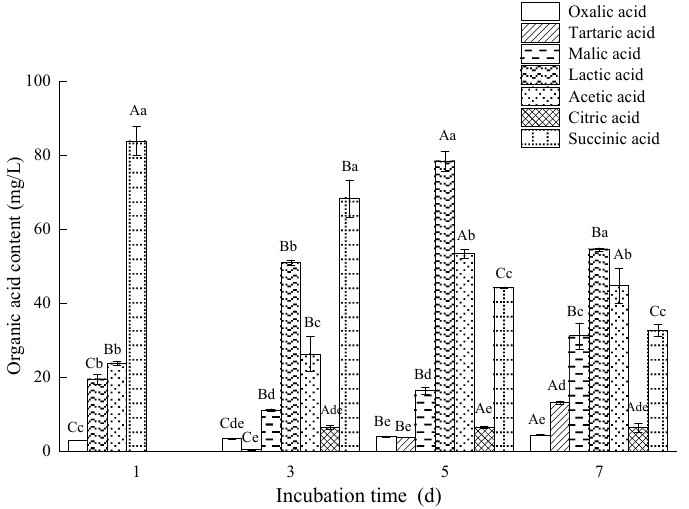
Figure 5. Concentration of various organic acids secreted by L4 at different culture times. Different capital letters indicate a significant ( p < 0.05) difference in the content of the same organic acid; different lowercase letters indicate significant ( p < 0.05) differences in different organic acid contents in the same day.